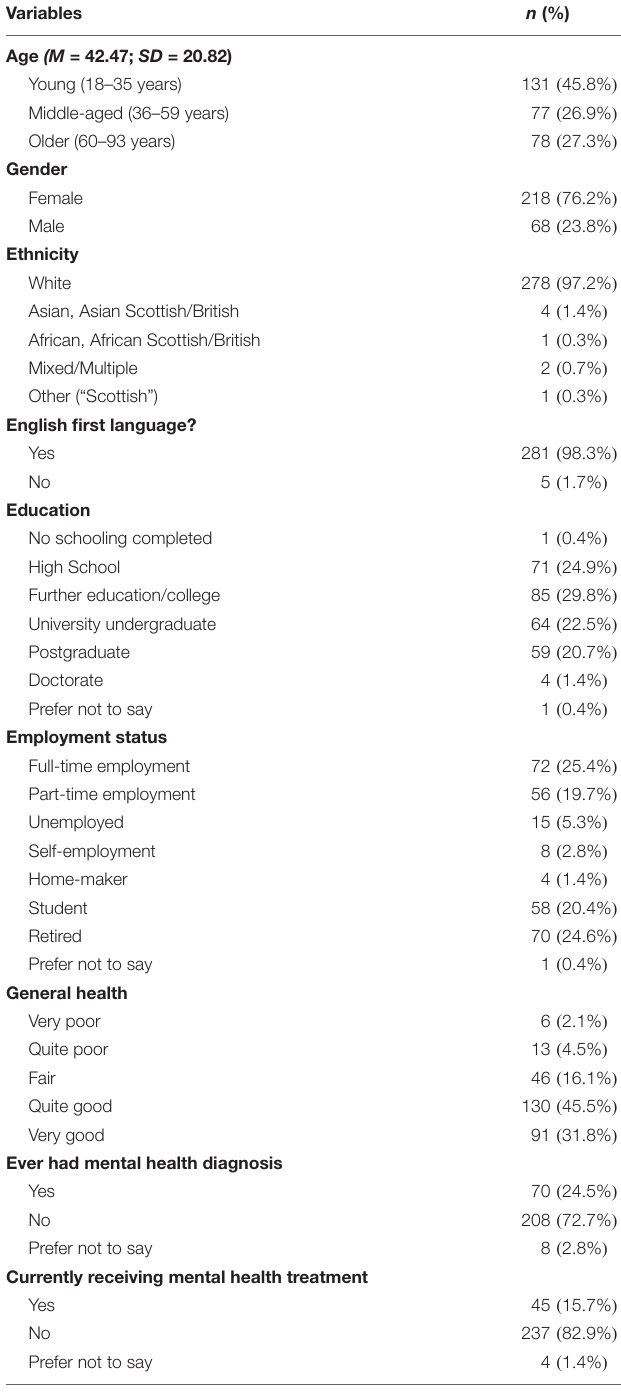
TABLE 1 | Participants’ socio-demographic